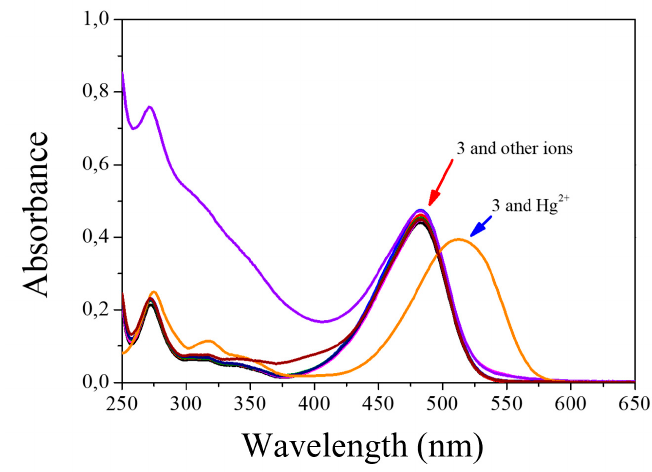
Figure 8. Changes in the absorbance spectra of 3 (5 × 10 − 6 M) upon addition of ions (1 × 10 − 4 M) in H 2 O:EtOH 80:20.